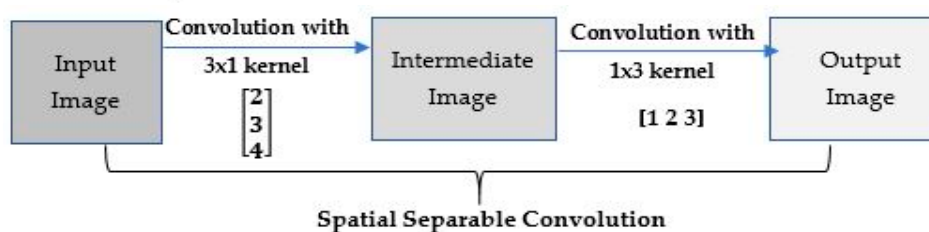
Figure 6. Depth-wise convolution uses three kernels to produce an 8 × 8 × 1 image from a 12 × 12 × 1 image.